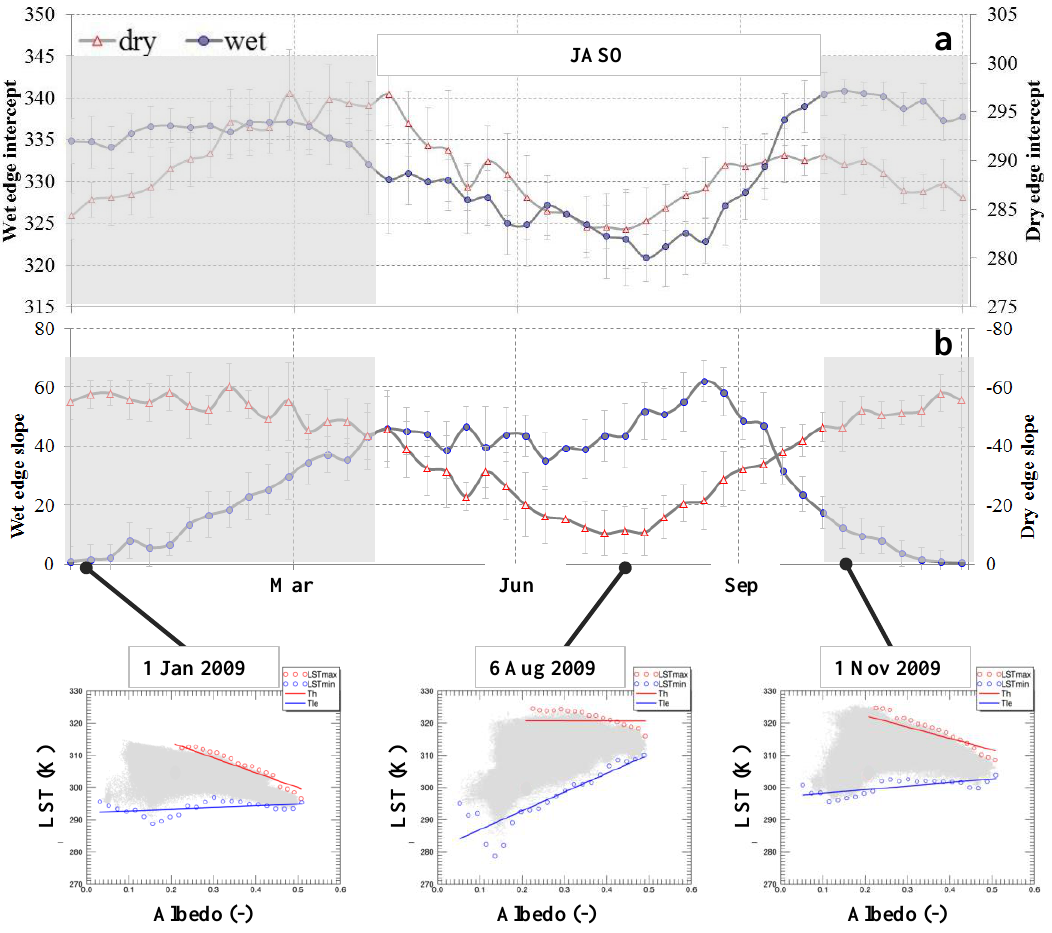
Figure 4. Eight-day average values of the intercept ( a ) and slope ( b ) obtained from dry and wet edge lines for the 2000–2009 period. Shaded gray areas represent the dry season. Plots show three albedo-LST scatterplots for the year,